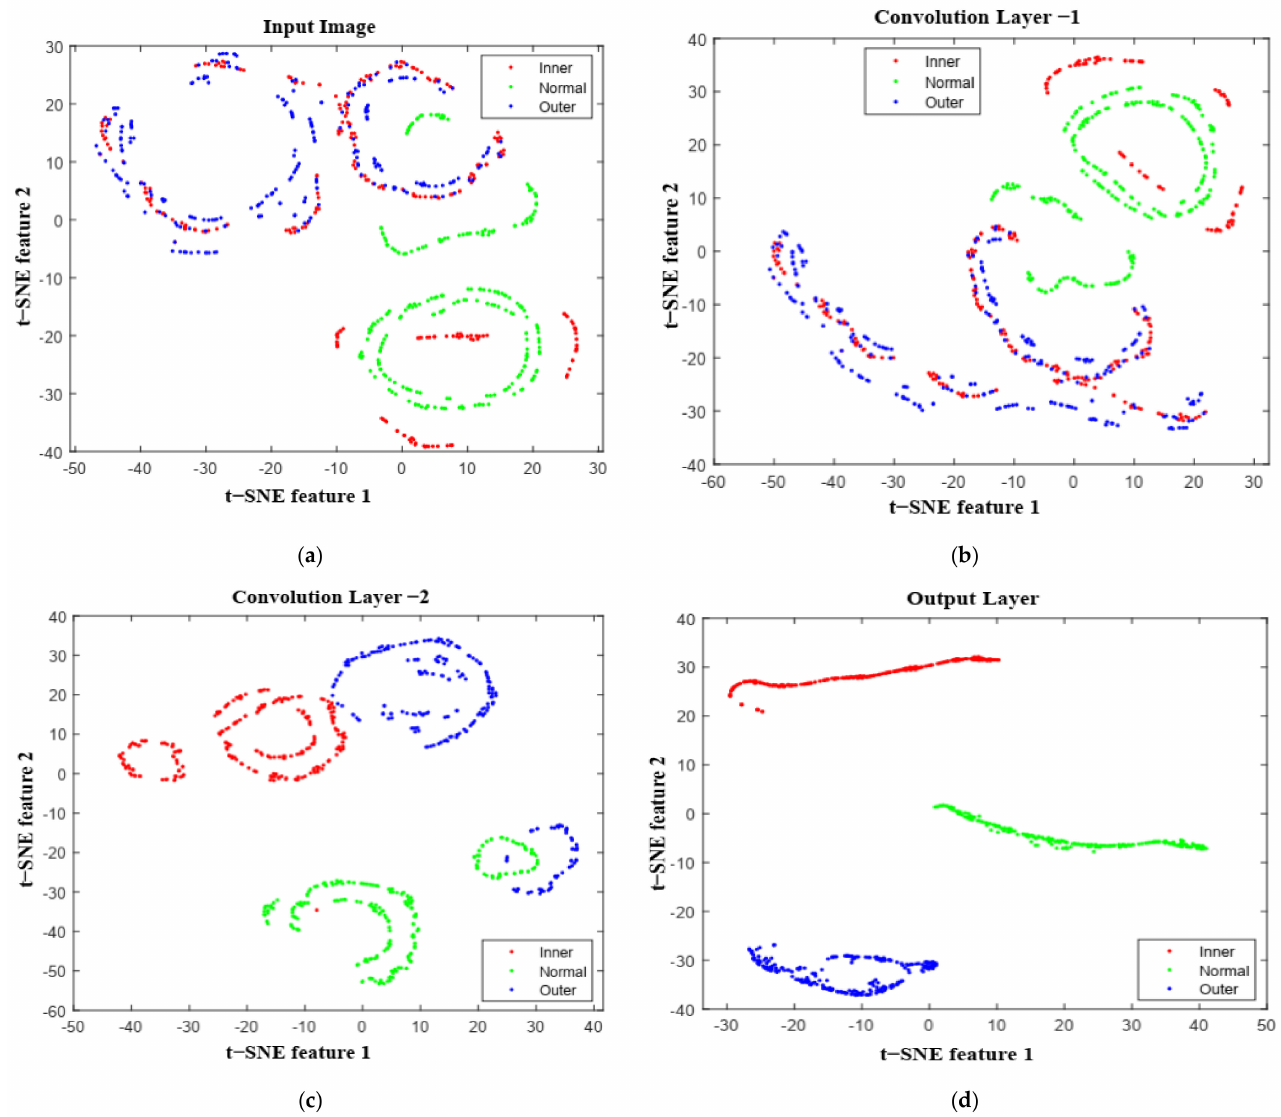
Figure 10. Feature visualization via t − SNE: ( a ) input image; ( b ) initial convolution layer; ( c ) final convolution layer; and ( d ) output